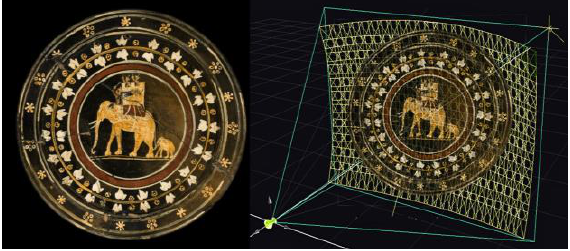
Figure 8. Giga Image and images stitching